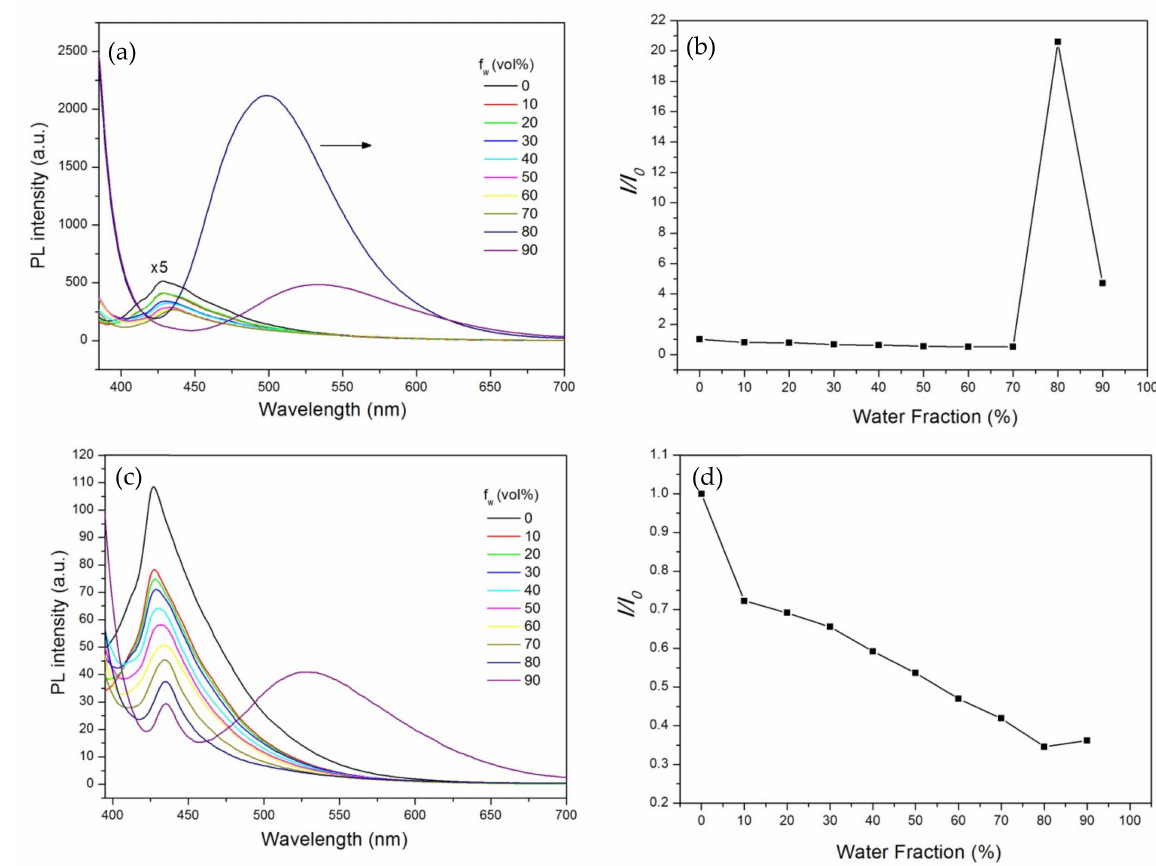
Figure 3. ( a , b ) PL spectra and changes in relative PL intensity versus different water fractions of n-TPE (The chosen wavelength for the calculation of “ I / I 0 ” is 430 nm for 0–70%, 498 nm for 80%, 532 nm for 90%); ( c , d ) n-TPE-AP-PDMS in THF/water mixtures. λ ex = 375 nm; concentration: 10 µ M. (The chosen wavelength for the calculation of “ I / I 0 ” is 430 nm for 0–80%, 533 nm for